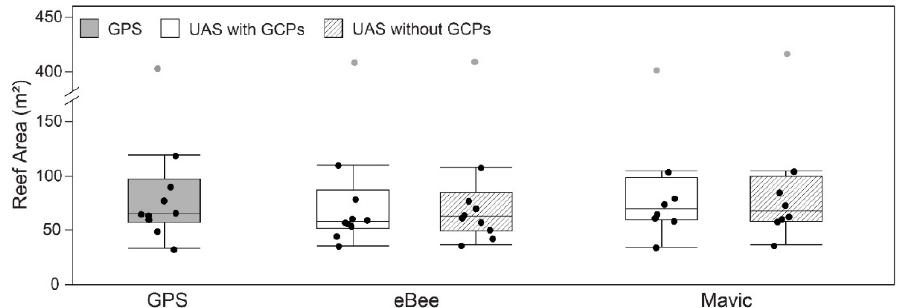
Figure 4. Reef areas calculated from a real-time kinematic (RTK) global positioning system (GPS) perimeter and two UAS (senseFly eBee fixed-wing and DJI Mavic Pro quadcopter) that were processed with and without ground control point (GCP) correction. Table 1. Global positioning system ( GPS) and unoccupied aircraft system (UAS)-derived intertidal oyster reef area measurements in m 2 from five reefs located in Town Marsh and Middle Marsh. Only three intertidal reef area measurements are included in the Mavic flights at Middle Marsh due to a small flight extent. Percentage of reef area differences are shown in parentheses.